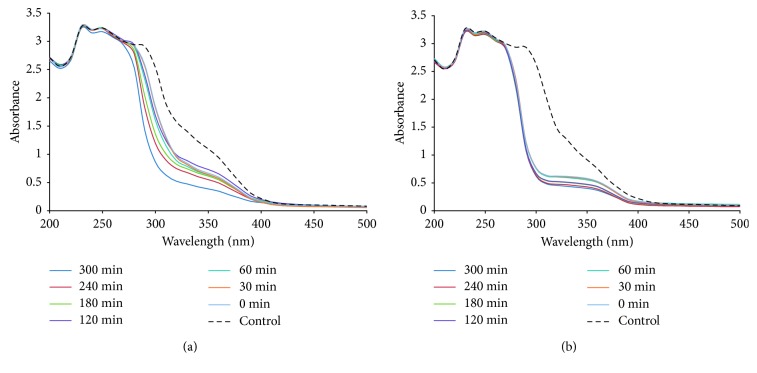
UV-Vis spectra recorded at different time intervals for nanoparticle formation using GSTE at 100°C with (a) 1 mM H2PtCl6·6H2O solution and (b) 1 mM PdCl2 solution. Control represents corresponding salt solution without GSTE.